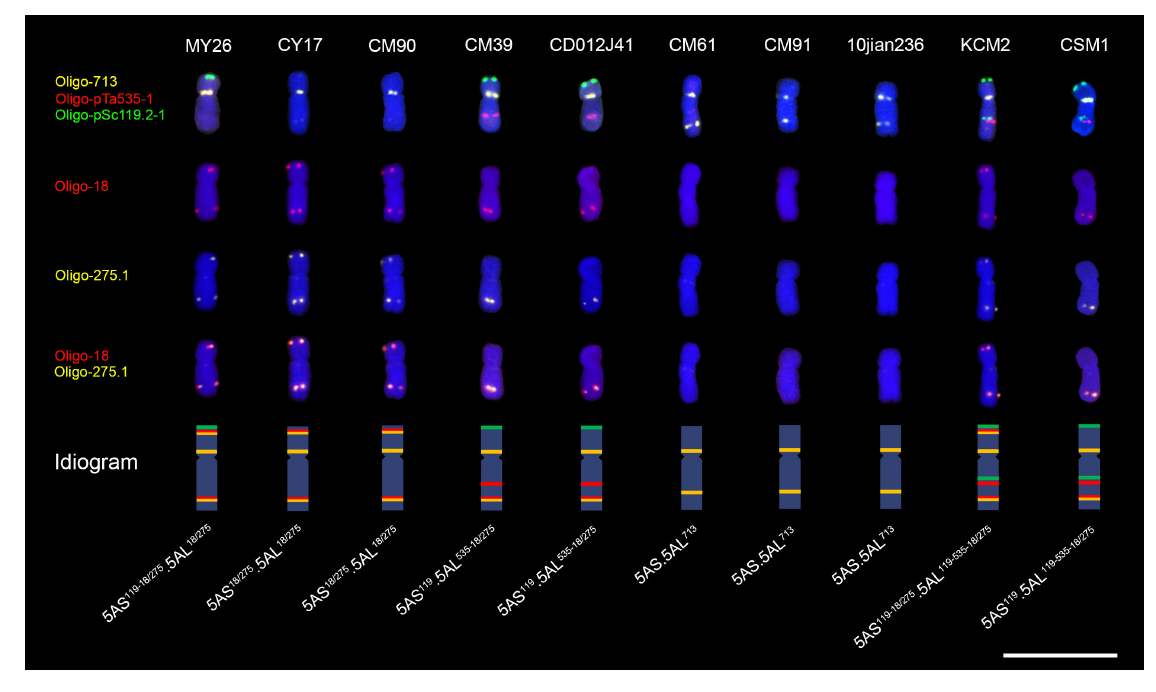
and so on. The number of each type of 5A chromosome in F 2 generation plants was